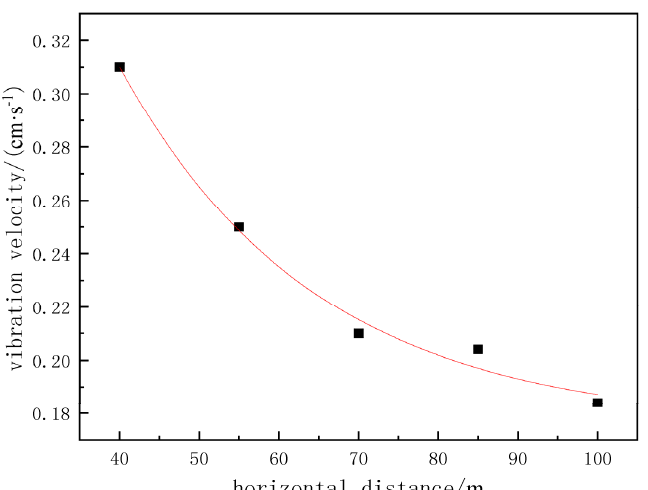
Figure 4. Variation of vibration velocity of surface dwellings with horizontal distance from the explosive center.